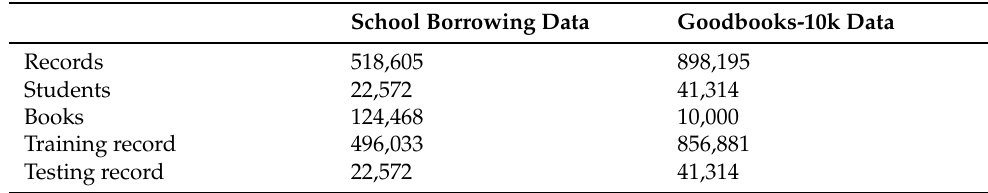
Table 1. Statistics of the Datasets.